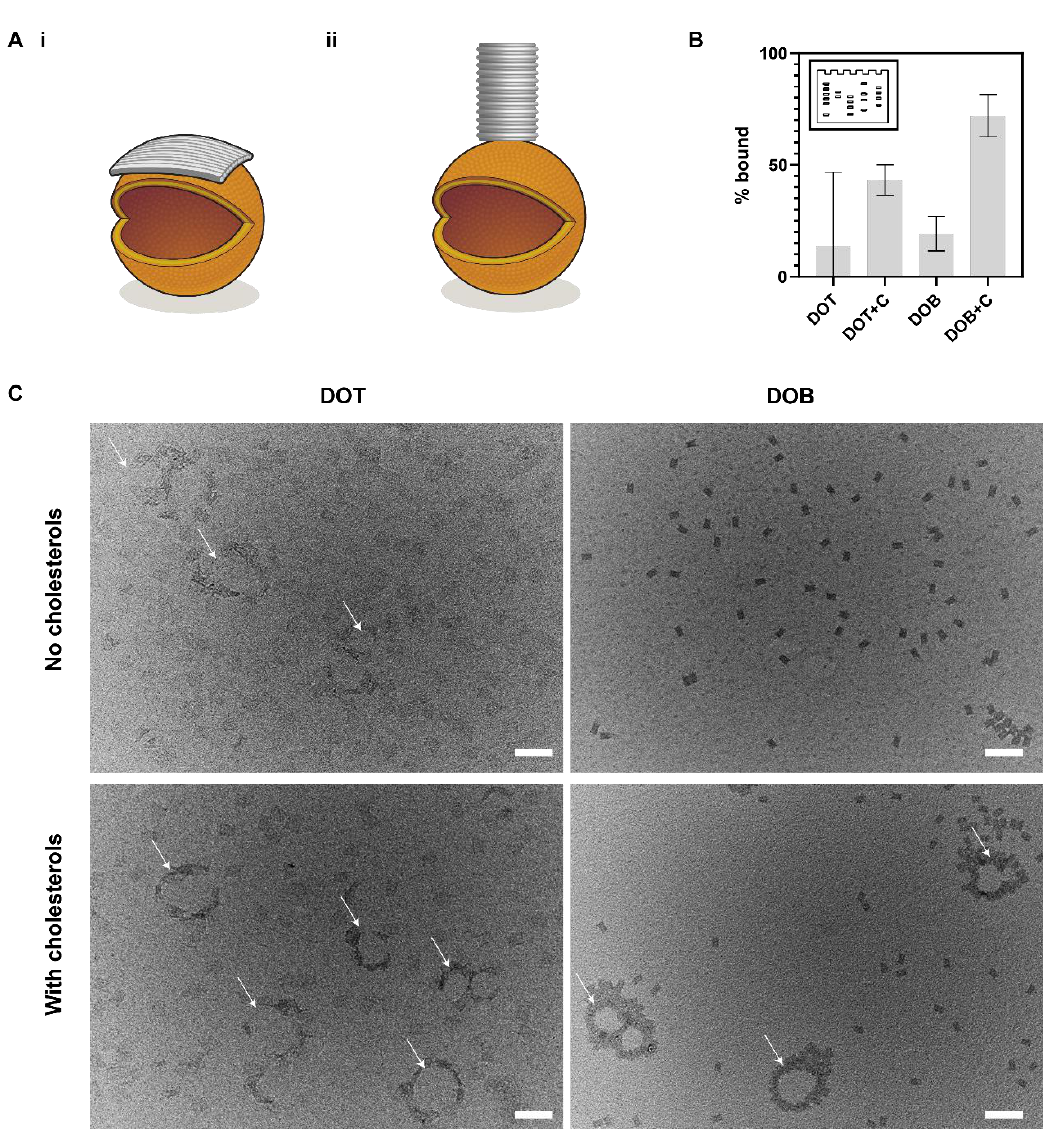
Figure 5. Membrane binding. ( A ). Schematic showing the binding of a DOT ( i ) and DOB ( ii ) to an SUV (orange) for the proximal spacer design; ( B ). Bar chart showing the % bound based on the gel-shift assay. The error bars are from two gel repeats (mean plus standard deviation); ( C ). TEM images showing the membrane binding of the DOT and DOB in the absence and presence of cholesterols. While liposomes are not visible in these conditions, clustering of DOT and DOB around circular voids indicate regions of liposome binding (white arrows). Scale bar: 200 nm.